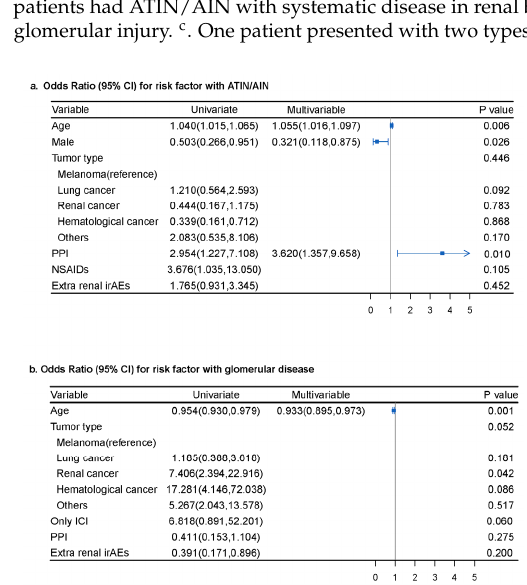
Figure 2. Factors associated with the occurrence of renal adverse events with ATIN/AIN and glomerular disease. ( a ) Male sex, older age and PPI treatment were associated with ATIN/AIN in multivariable analysis; ( b ) older age was inversely associated with glomerular diseases after adjusting for confounders. ATIN/AIN: acute tubulointerstitial nephritis/acute interstitial nephritis; PPI: proton pump inhibitor; ICI: immune checkpoint inhibitor; CI: confidence